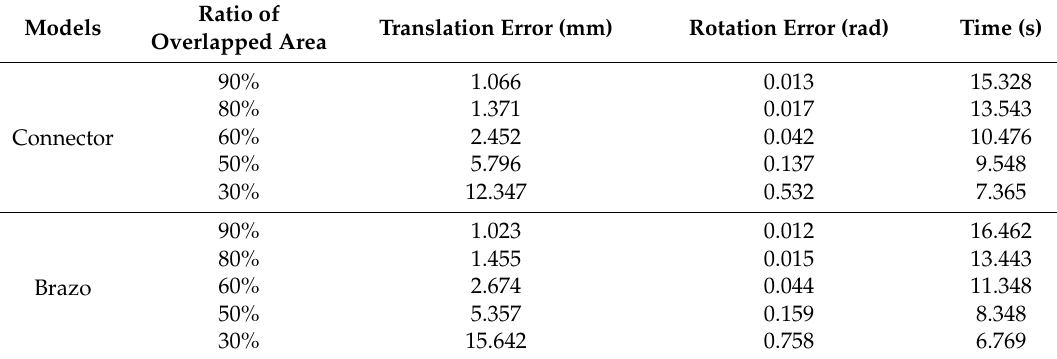
Table 3. Experimental results using the connector model obtained by the proposed coarse registration method with different ratios of overlapped